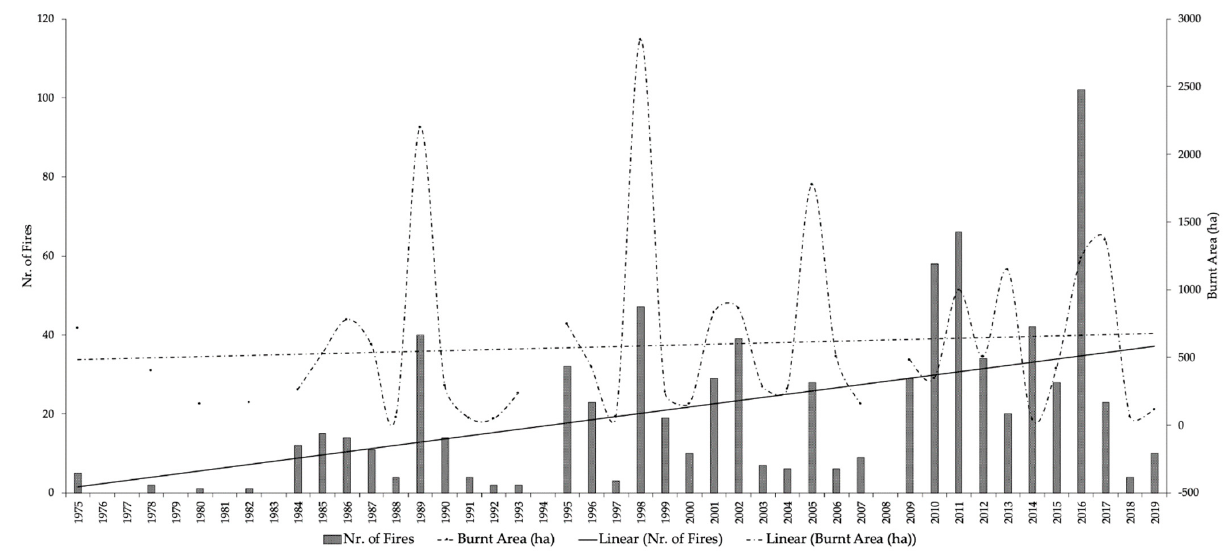
Figure 12. Occurrences of rural fires and burnt areas in 1975 to 2019.